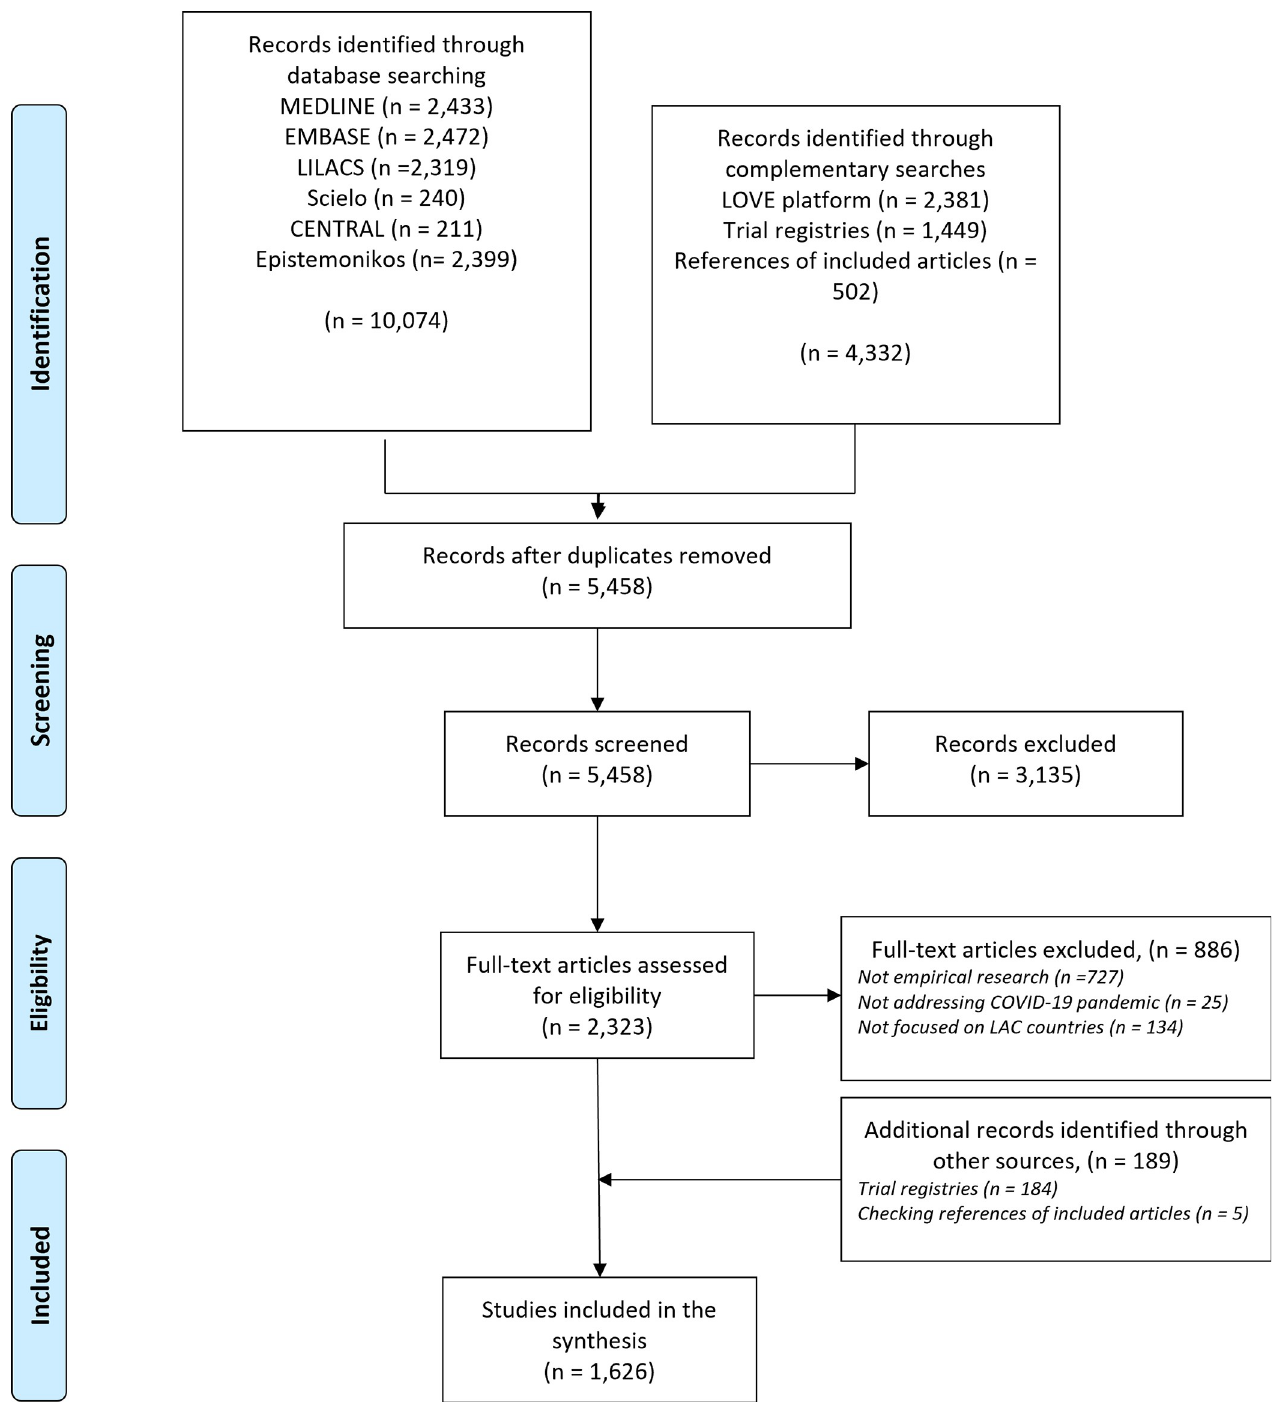
Fig 1. Flow diagram for the scoping review of empirical research related to COVID-19 in LAC countries.